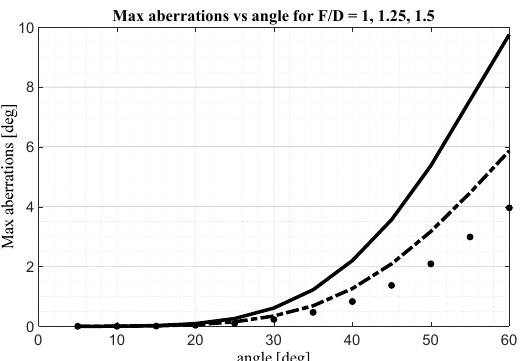
Figure 7. Maximum aberrations [degrees] as a function of the maximum scanning angle [degrees] for three different values of the F/D. Continuous line: F/D = 1; dashed curve: F/D = 1.25; dotted curve: F/D = 1.5. Table 5. Aberrations and lateral focal distance for lenses having h/D = 10/3, M = 1.